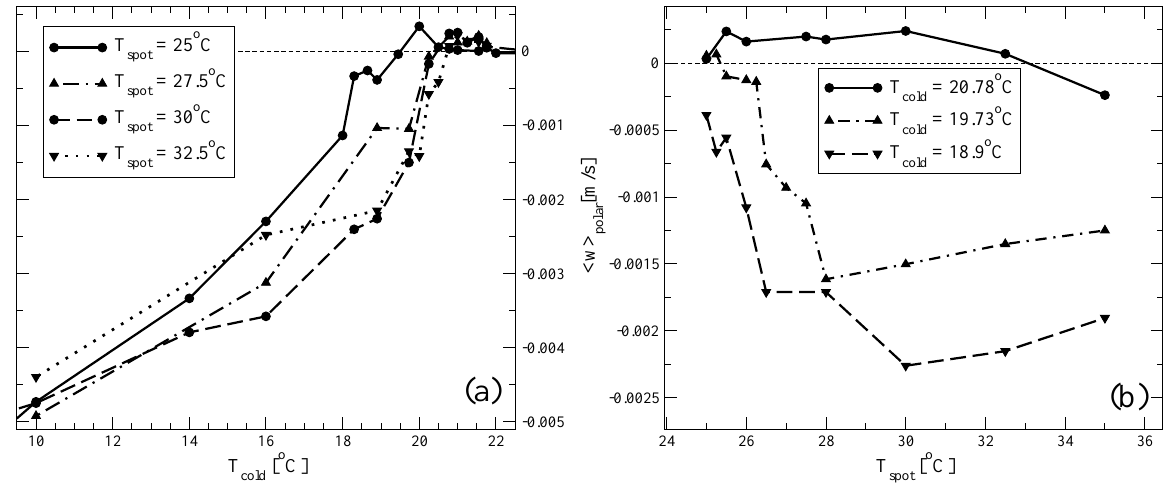
Fig. 4. (a) h w i polar as a function of T cold , for four different values of T spot , see legends. (b) Dependence of the same quantity h w i polar on T spot , for three fixed values of T cold , see legends.